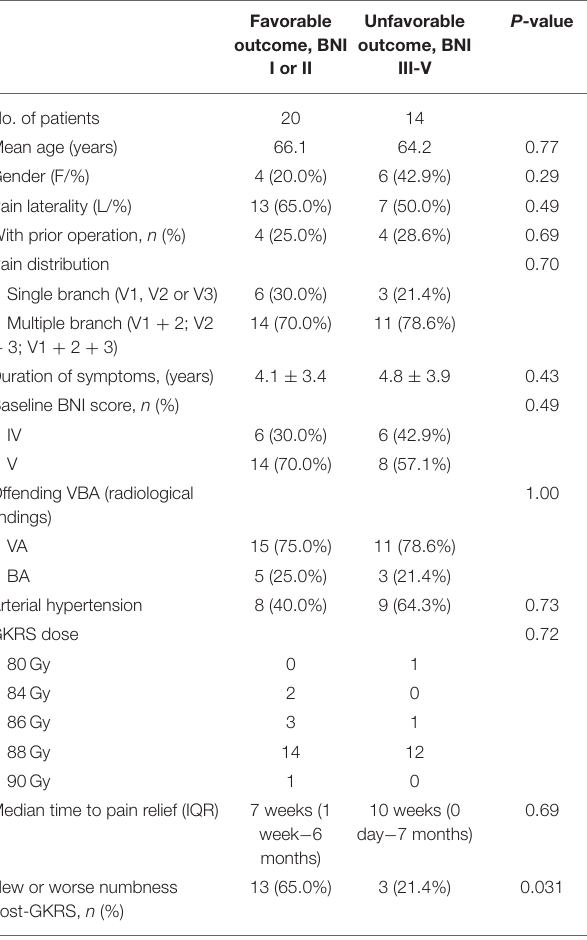
TABLE 3 | Comparison of clinical factors between favorable outcomes and unfavorable outcomes in the MVD group.